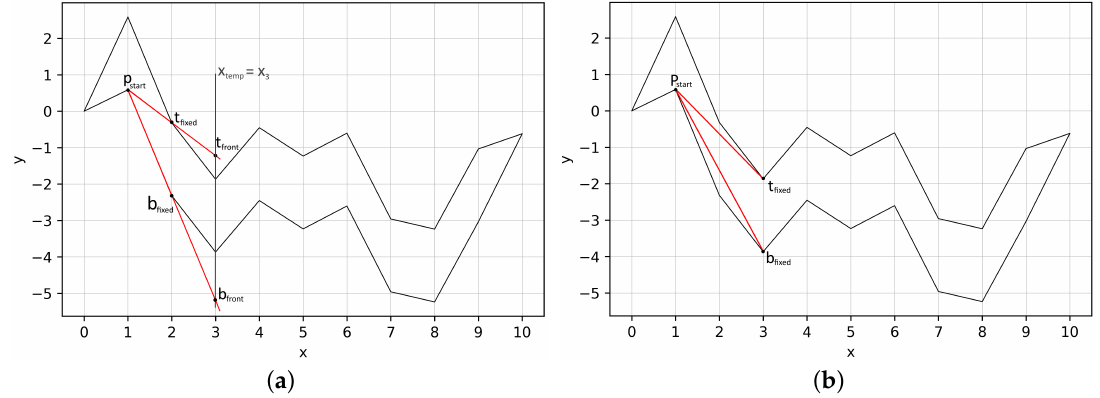
Figure 7. ( a ) Scanning cone with temp = 3; ( b ) correction of the